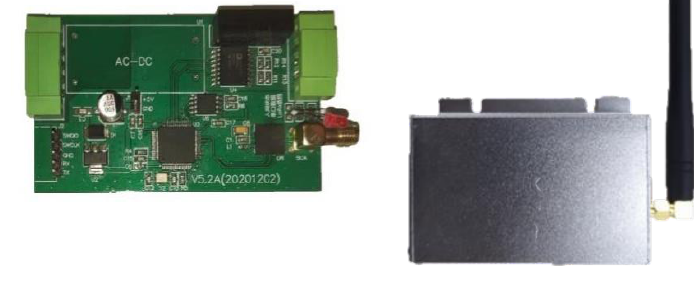
Figure 9. ED hardware